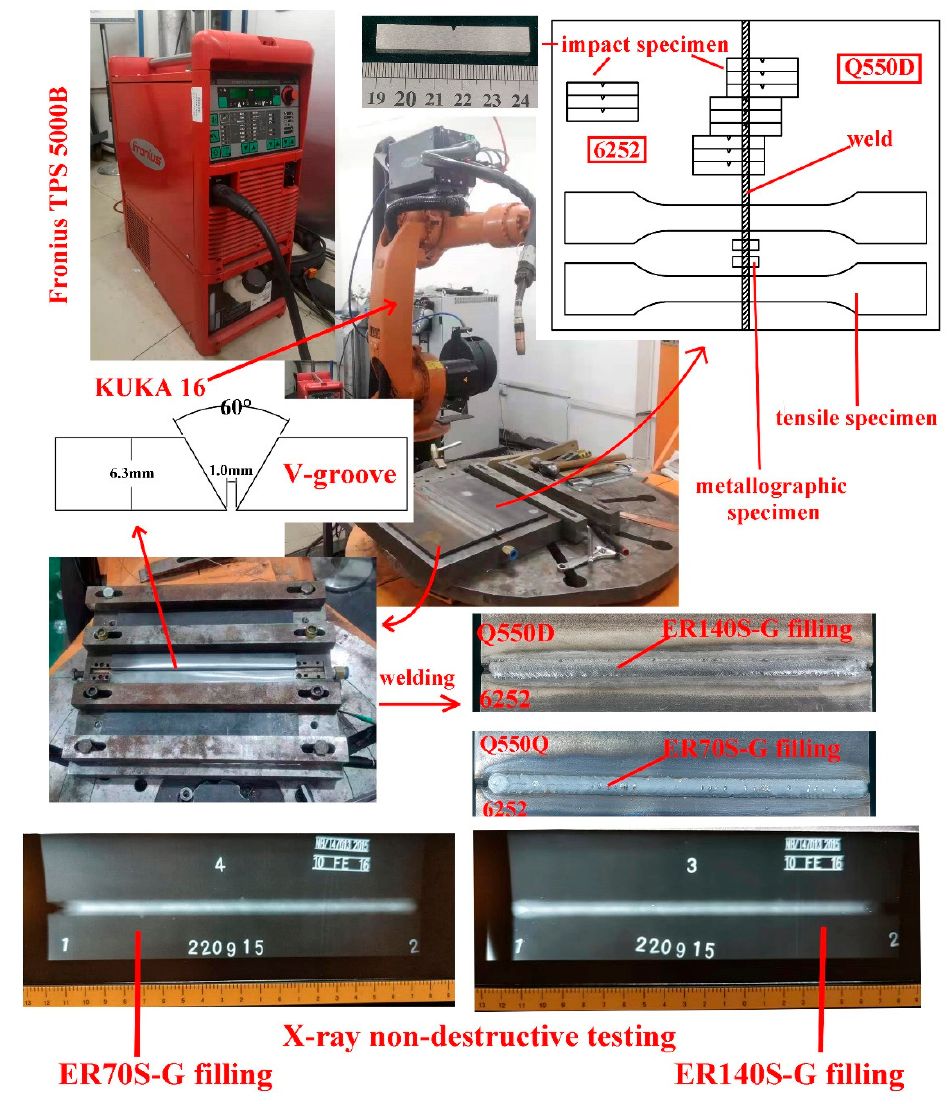
Figure 1. Flow chart of the experimental process.